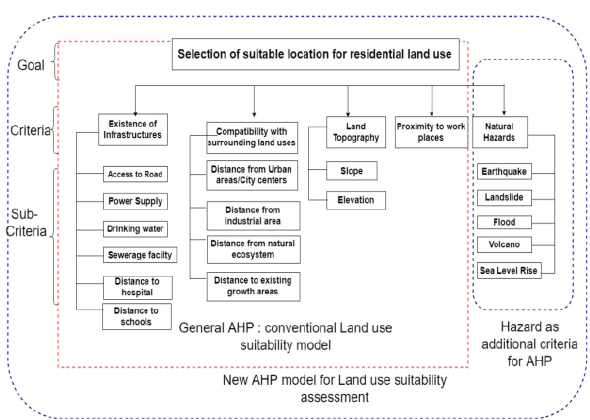
Figure 1. A hierarchical model setup in SuperDecisions for residential land-use suitability